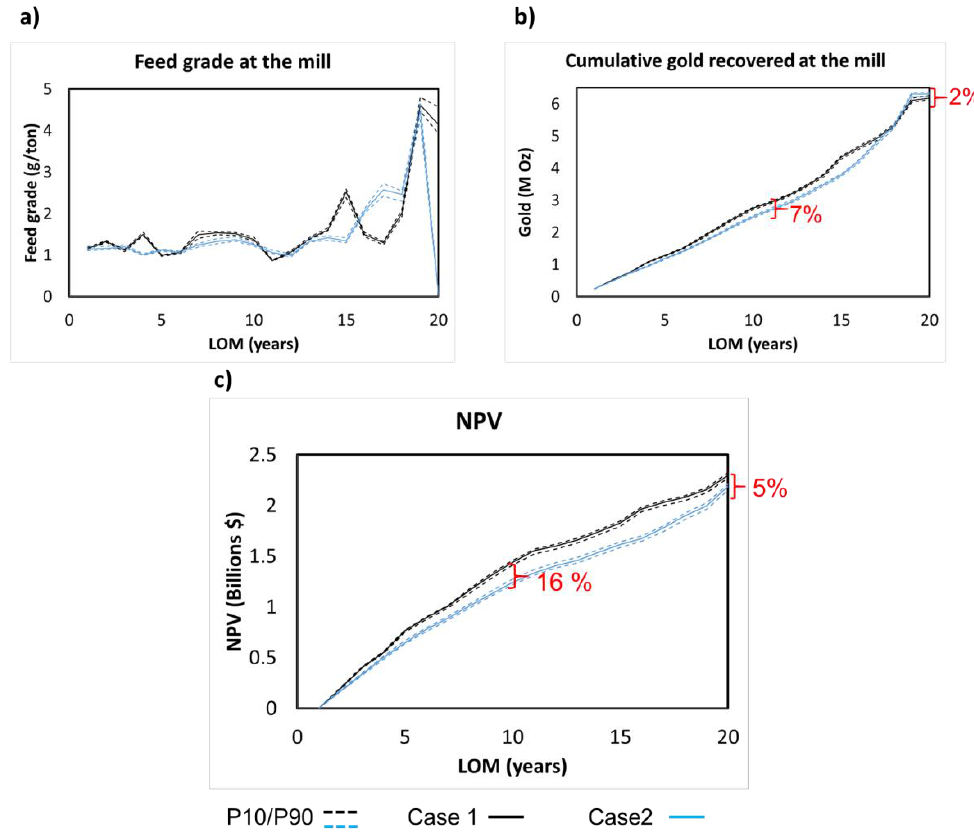
Figure 10. Risk analysis of production forecasts for ( a ) head grade at the mill; ( b ) cumulative gold recovered at the mill and ( c ) NPV assessment. P10 and P90 representing the 10th and 90th percentiles, respectively.